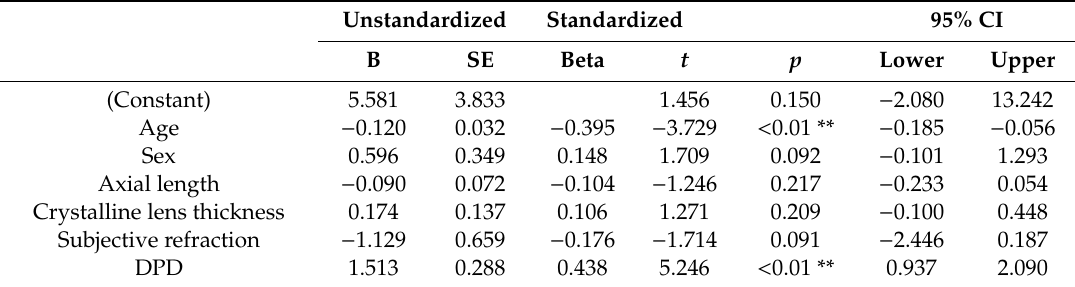
Table 4. Multiple regression analysis in the young group (22–44 years old, n = 70 and adjusted R 2 = 0.579).